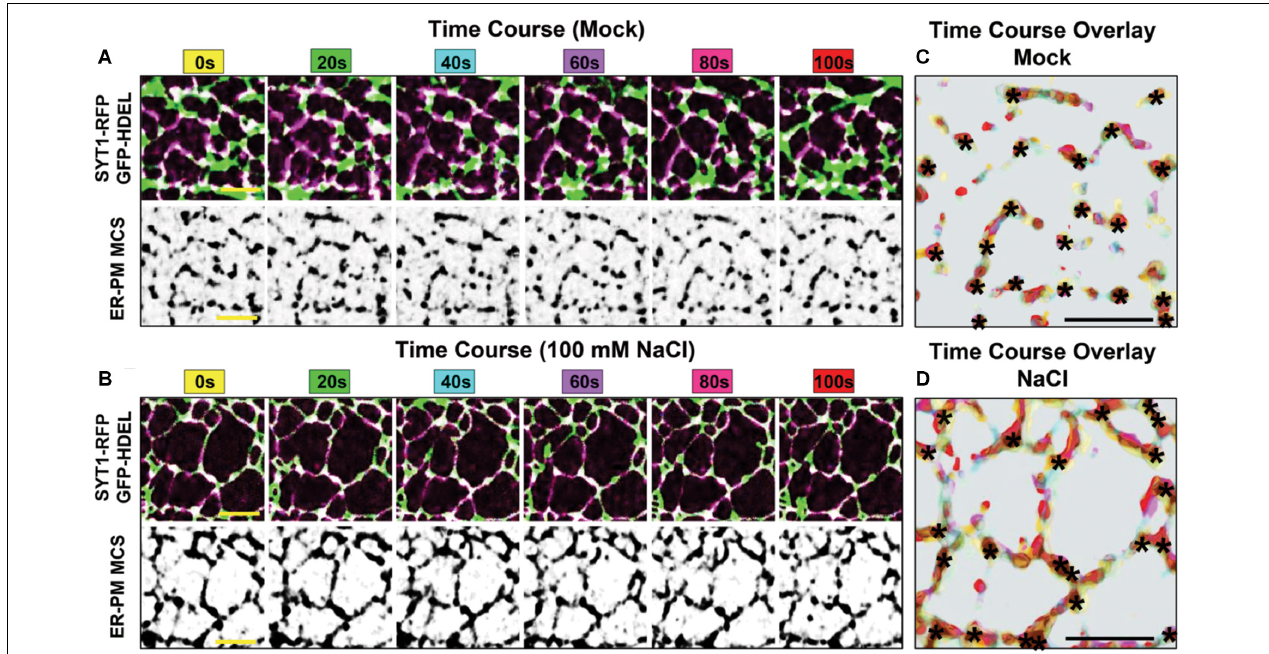
FIGURE 3 | Environmental regulation and dynamics of SYT1-labeled ER-PM MCS in Arabidopsis seedlings. (A,B) Time course co-localization of SYT1-RFP ER-PM MCSs (purple) with the luminal ER marker GFP-HDEL (green). 5-day-old Arabidopsis cotyledon epidermal cells where treated with mock (A) or ionic stress (100 mM NaCl) (B) for 8 h prior to imaging. For the subsequent 100 s time course overlay, SYT1-RFP is shown corresponding black and white panels. (C,D) The time course overlay of SYT1-RFP dynamics in A and B is shown in panels (C,D) , respectively. Each color in the overlay represents the position of the SYT1-RFP signal at the corresponding 20 s interval. Asterisks mark where SYT1-RFP nodes are static throughout the time course. Bars = 5 mm.